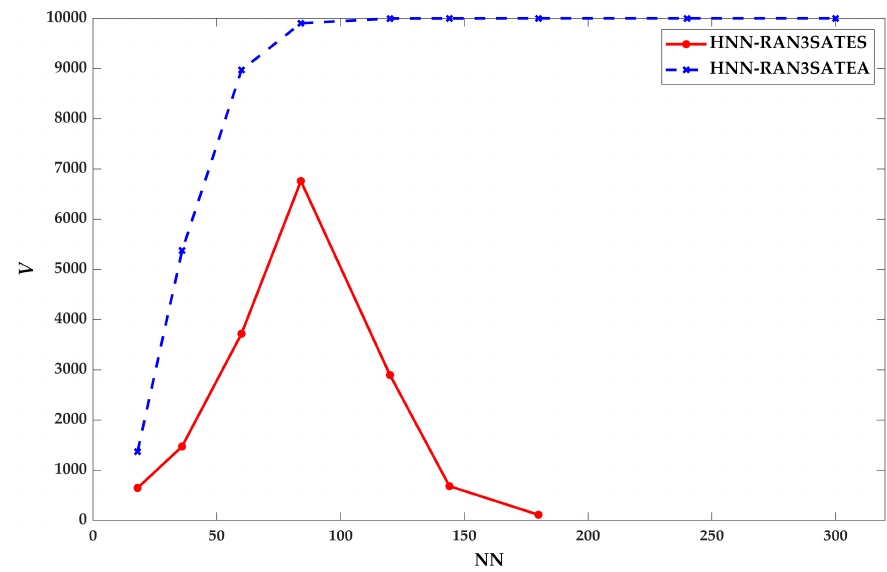
Figure 14. V (Neuron Variation) for HNN-RAN3SAT model.